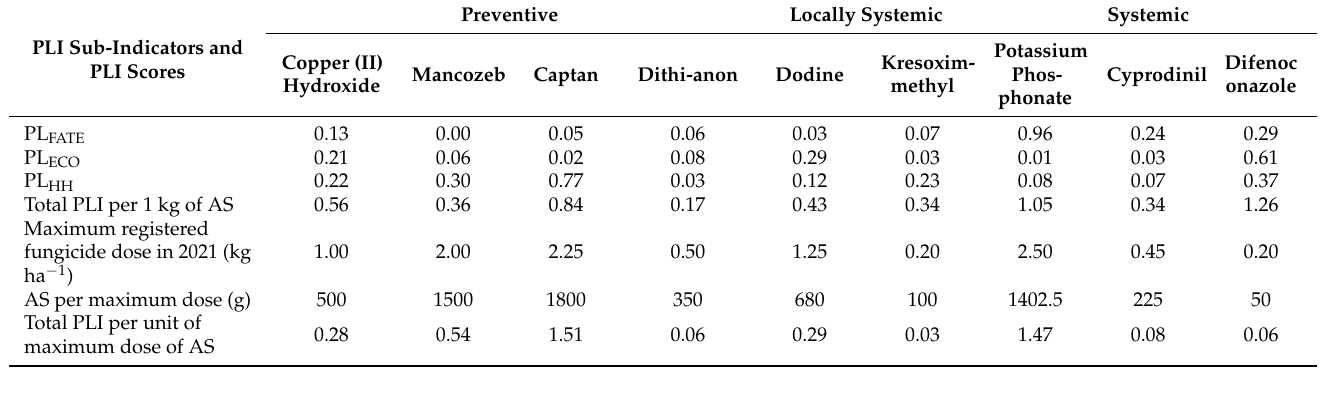
Table 5. Pesticide Load Indicator (PLI) sub-indicators: Environmental fate (PL FATE ), Ecotoxicology (PL ECO ), Human health (PL HH ) and total PLI score calculated per unit of the active substance (AS) and maximum dose of selected fungicides.